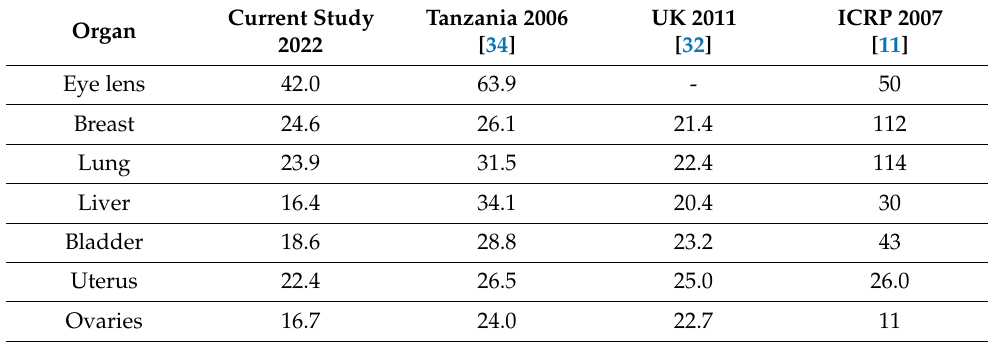
Table 3. Comparison between the mean organ dose in the current study and similar international